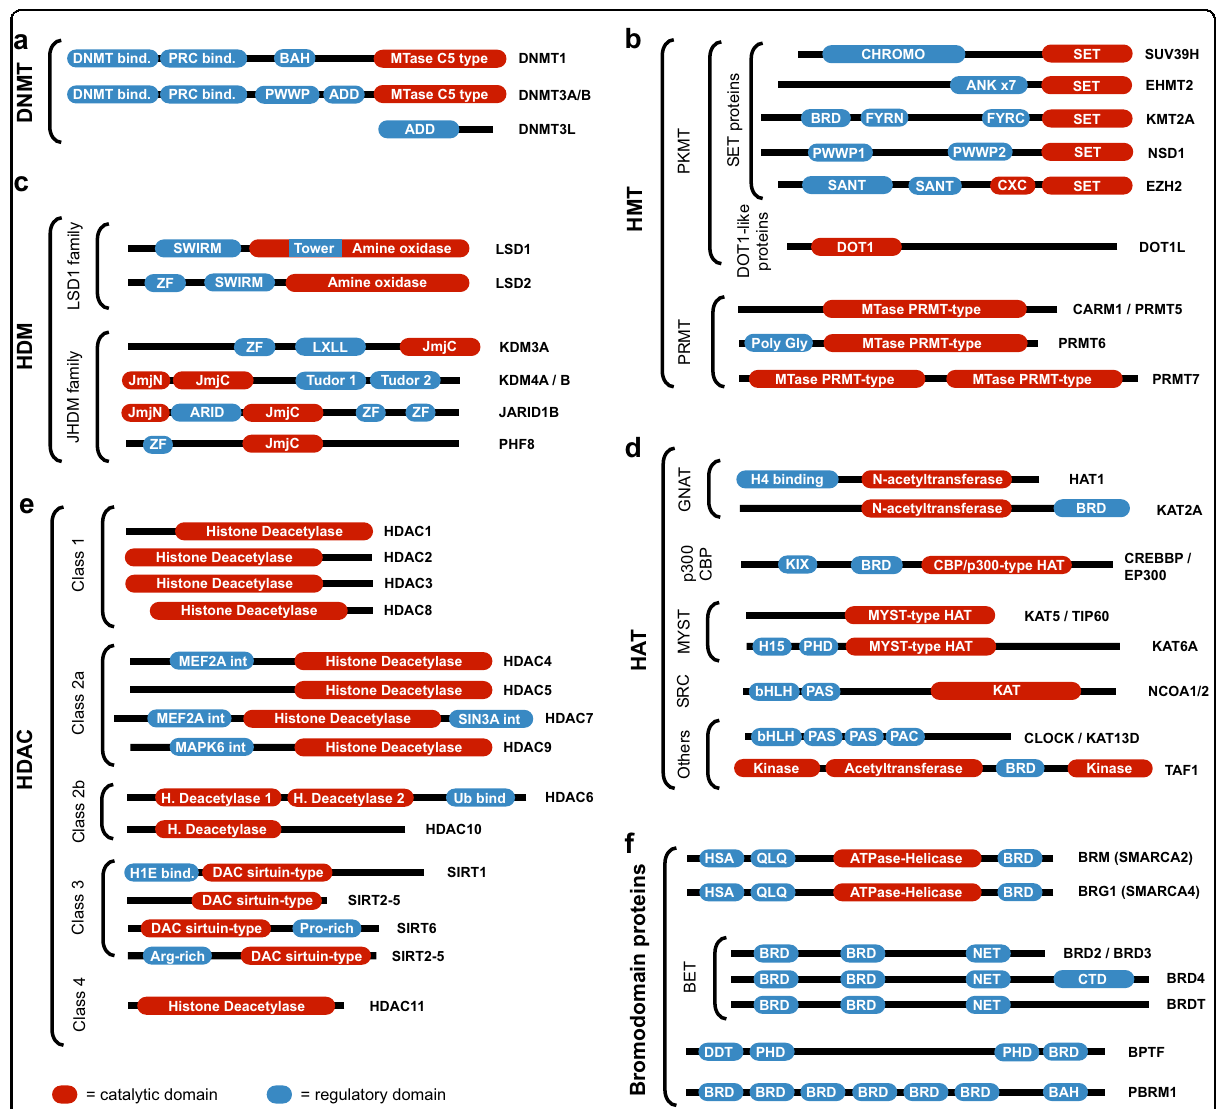
Fig. 2 Schematic representation of members of the main epigenetic regulator families and subfamilies. Representative members of a DNMT, b HMT, c HDM, d HAT, e HDAC, and f BRD-containing proteins are included, showing their domain con fi gurations and indicating the catalytic region, which is the main target of epigenetic drugs. Sources: UniProt 104 , InterPro 105